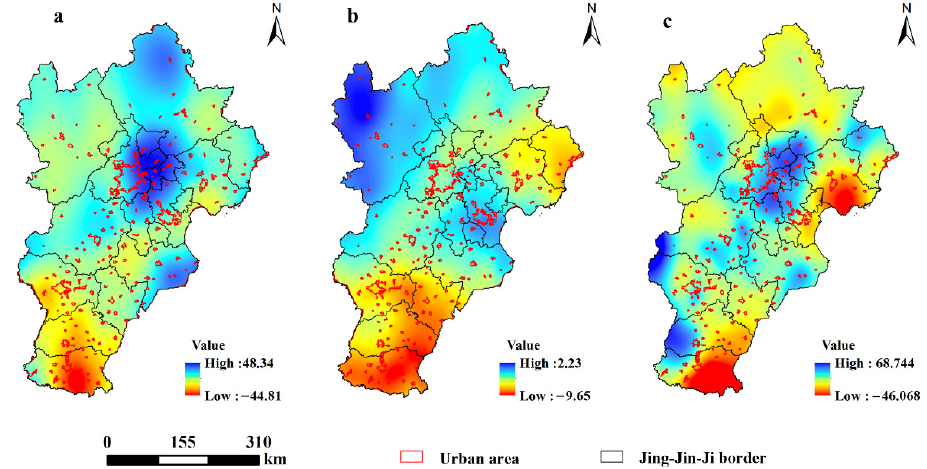
Figure 5. Spatial distribution of precipitation changes in different seasons in the Beijing–Tianjin–Hebei region (( a ), summer; ( b ), winter; ( c ), annual, units: mm).